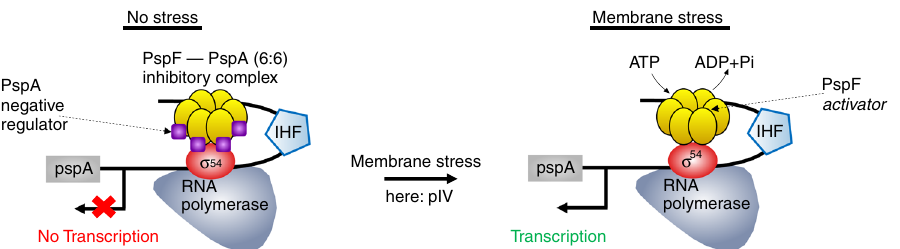
Fig. 5 Regulation of Transcription of the σ 54 controlled Psp system. The Psp system stabilises damaged inner membranes of bacteria 23,27 . Transcription of Psp is controlled by RNA polymerase/ σ 54 and requires ATP hydrolysis by the bacterial enhancer binding and activator protein PspF. In absence of membrane stress, the negative regulator PspA (as low-order oligomer) forms an inhibitory complex with PspF in a 6:6 ratio. PspA prevents ATP hydrolysis by PspF and thus Psp transcription. IHF bends the promoter DNA bringing the enhancer-bound PspF in contact with the RNA polymerase/ σ 54 . Membrane stress, e.g., through mislocalisation of proteins such as secretin pIV to the inner membrane enables the release of PspA from PspF. Subsequent ATP hydrolysis by PspF yields open complex formation and initiates Psp transcription. Additional information on the regulation of transcription of the σ 54 controlled Psp system can be found in Supplementary Figs. 11,